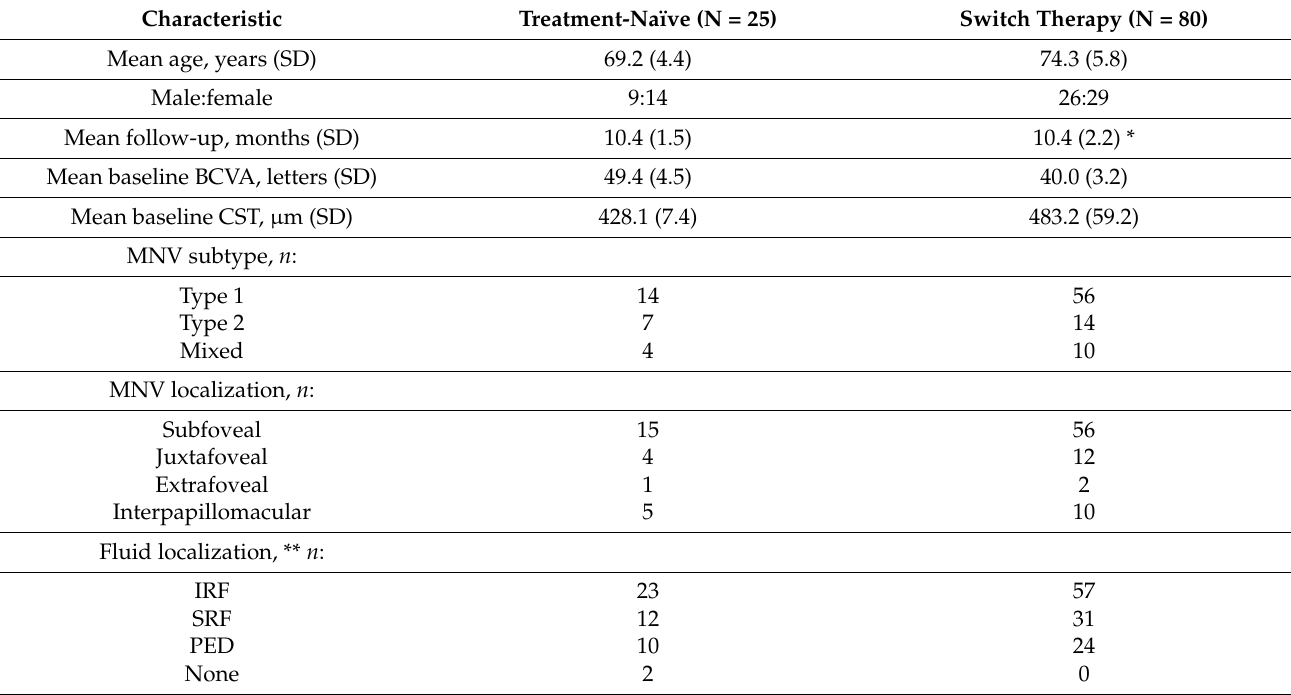
Table 1. Characteristics of patients who received brolucizumab